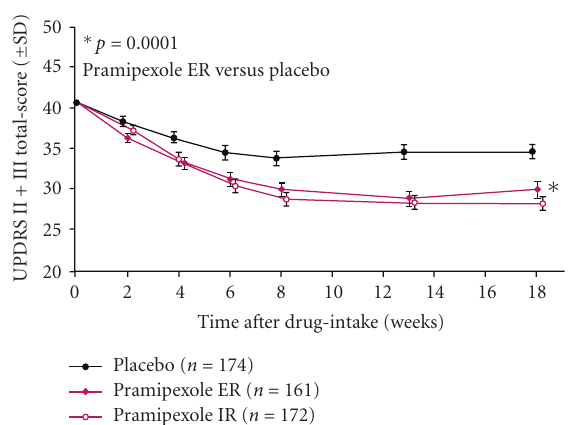
Figure 6: E ffi cacy of Pramipexole ER in patients with advanced Parkinson’s disease compared to pramipexole IR and placebo